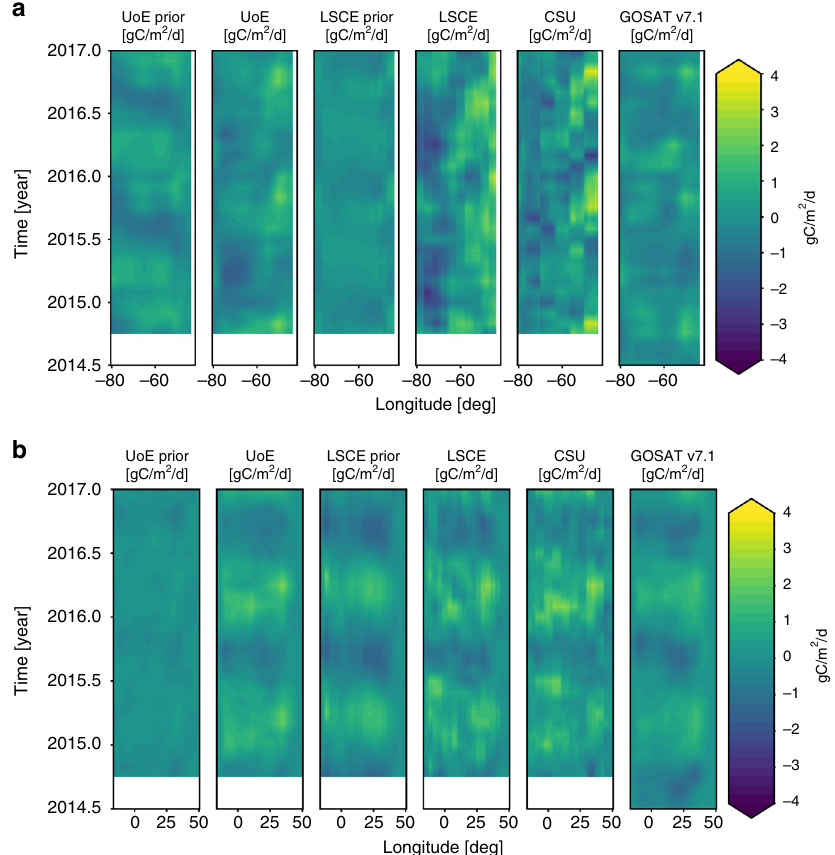
Fig. 3 CO 2 fl uxes from tropical South America and tropical northern Africa. Hovmöller plots of monthly a priori and a posteriori CO 2 fl uxes (expressed as gC m − 2 d − 1 , mid 2014 to 2017), averaged over the latitude domain, from a southern tropical South America and b northern tropical Africa, inferred from GOSAT and OCO-2 satellite measurements of X CO2 taken from the nadir observing mode. Positive fl uxes are from the land surface to the